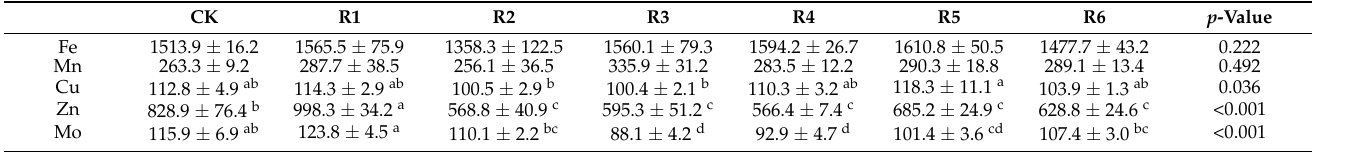
Table 4. Effects of rhizobia inoculation on the trace minerals in D. intortum